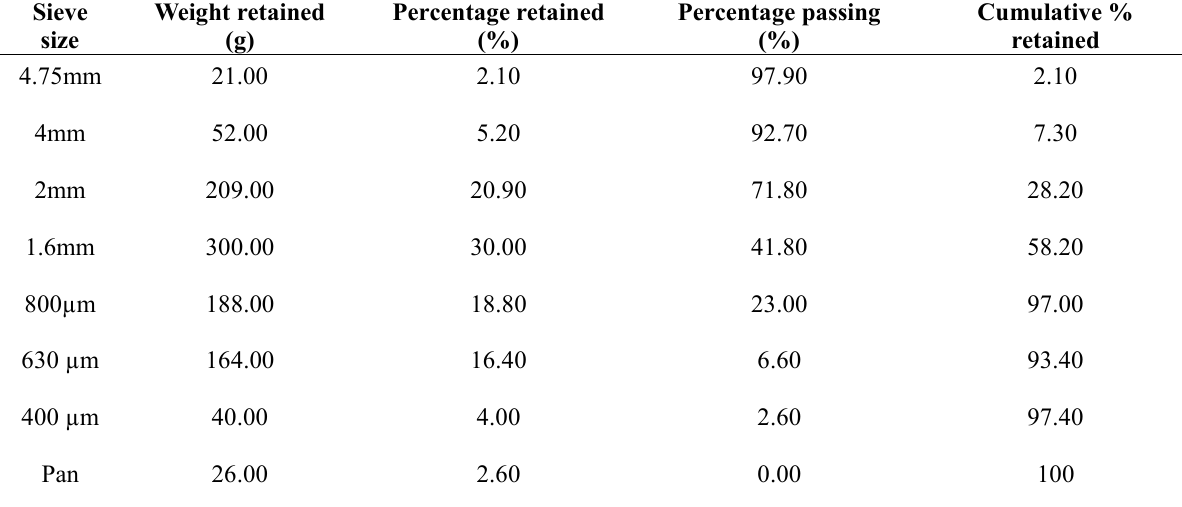
Table 1 Sieve analysis for fine aggregates.